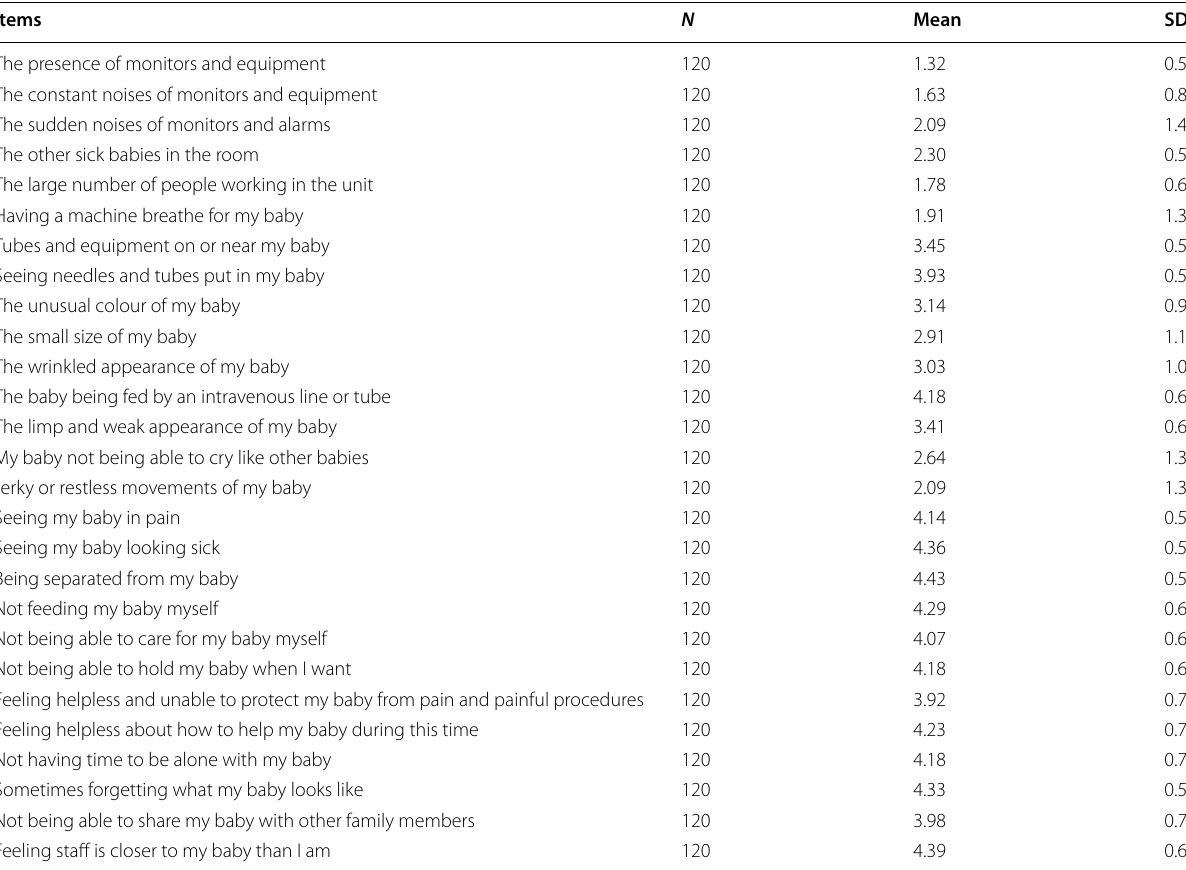
Table 5 Mean stress scores of each component of PSS: NICU scale